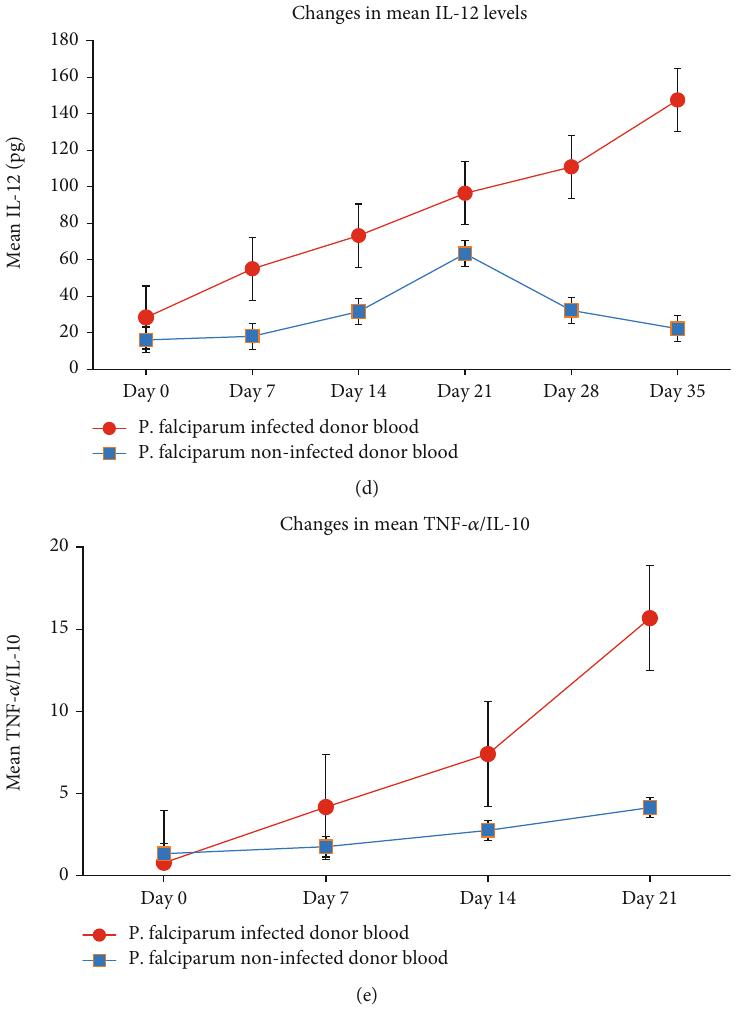
Figure 1: Changes in cytokine levels in donor whole blood stored for 35 days: (a) changes in TNF- α levels, (b) changes in IL-6 levels, (c) changes in IL-10 levels, (d) changes in IL-12 levels, and (e) changes in TNF- α /IL-10 levels. t -test determined P values to be < 0.05 in all cytokine levels for each timed point after storage between infected and noninfected donor